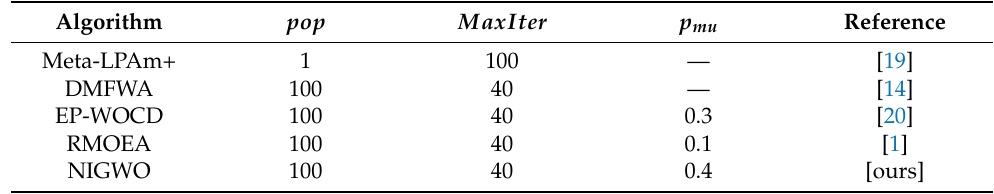
Table 4. Parameters setting of the compared evolutionary algorithms.